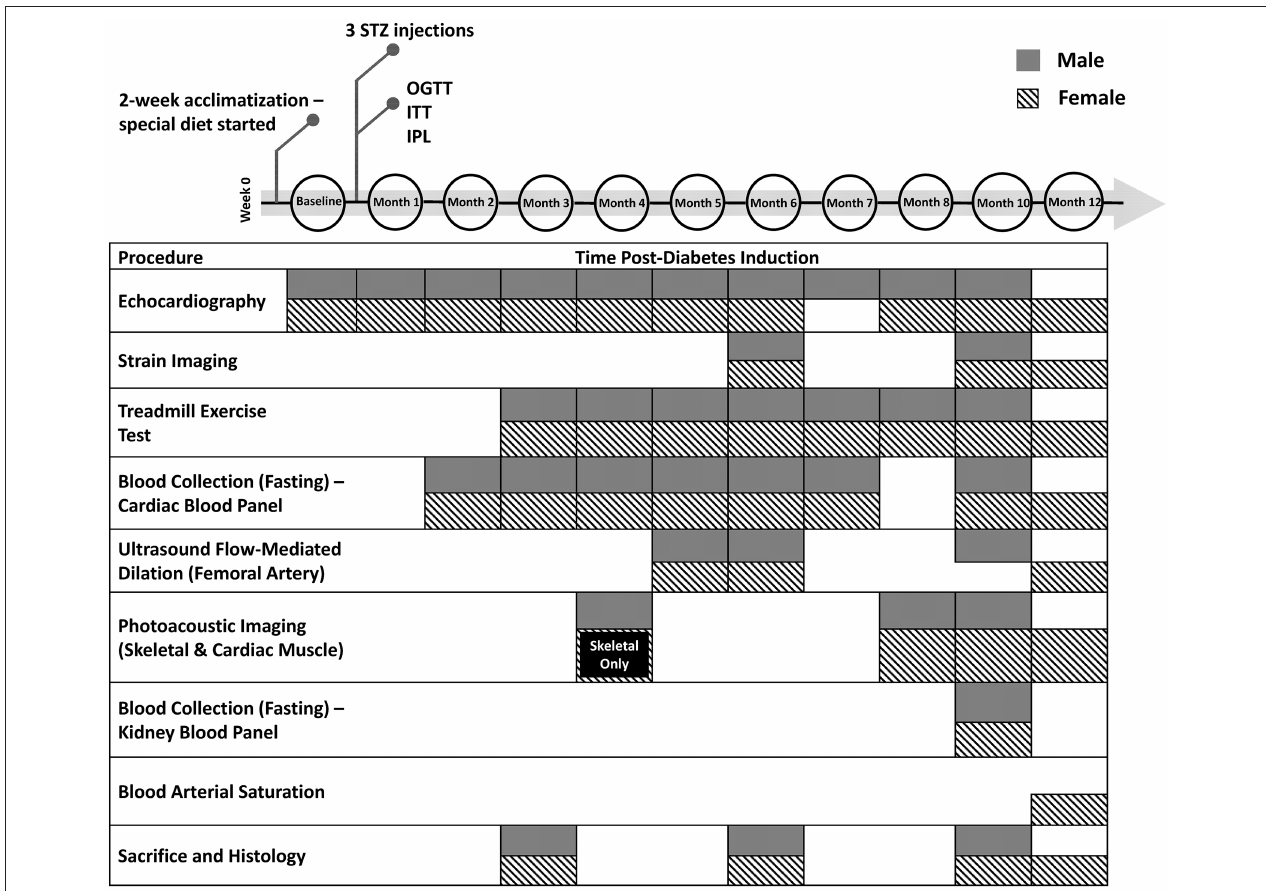
FIGURE 1 | Timeline of diabetes induction and post-induction monitoring and assessment. Additional measurements not shown include weekly weight, non-fasting blood glucose, and monthly blood pressure measurements. STZ, streptozotocin; OGTT, oral glucose tolerance test; ITT, insulin tolerance test; IPL, insulin plasma level